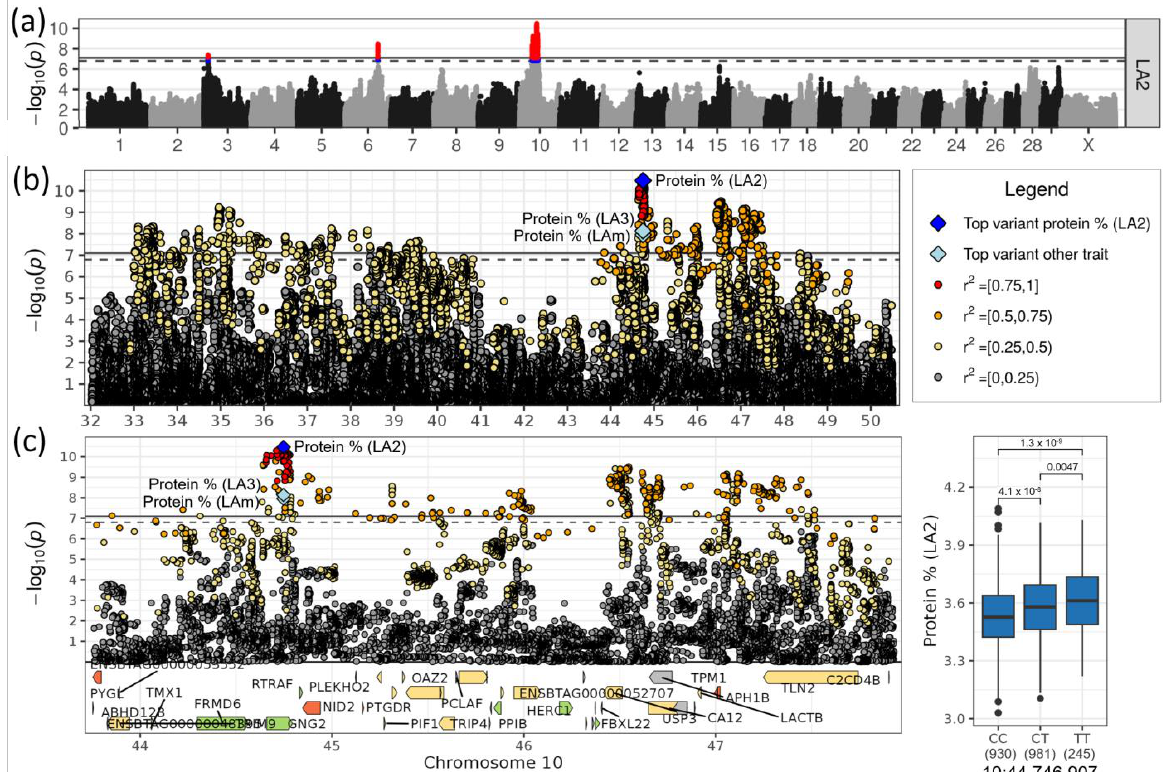
Figure 6. ( a ) Regional association plot for QTL for protein content on chromosome 10. ( b ) Zoomed regional association plot including genes and effect plot for top SNP for protein content in LA2. ( c ) Zoomed regional association plot including genes and effect plot for top SNP for protein content in LA2. Genes containing variant(s) with low, moderate or high impact are colored green, yellow and orange, respectively, and are otherwise grey.